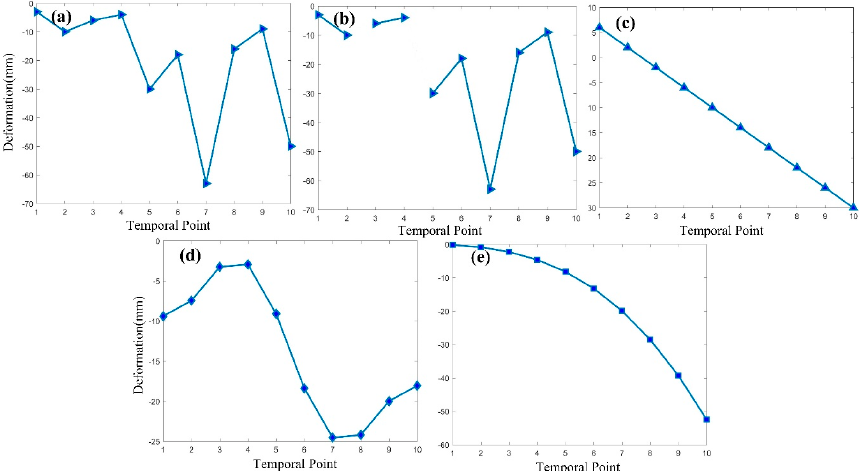
Figure 1. Simulated dynamic deformation on a ground surface point for 4 models: ( a ) MVM without temporal gap; ( b ) M VM with temporal gap; ( c ) PVM; ( d ) SM;( e ) CPM .